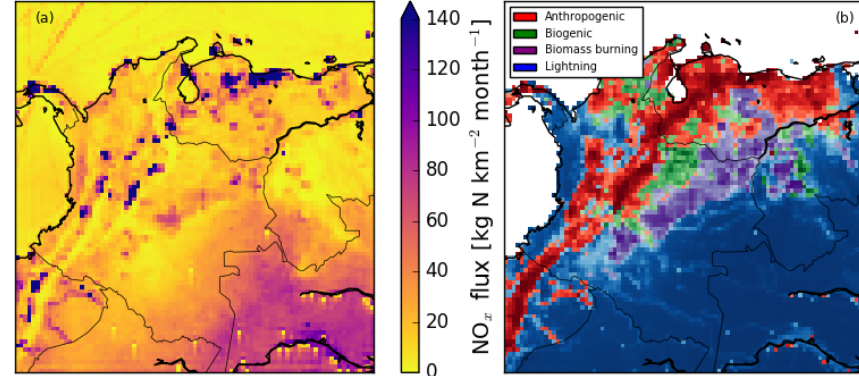
Figure 4. Spatial distribution of (a) the total NO x flux (kgNkm − 2 per month) in January 2014 and (b) the dominant emission source per grid cell over land. In panel (b) the saturation of the color indicates the percentage of the total NO x flux coming from the dominant emission source and increasing to 100% for the darkest colors.